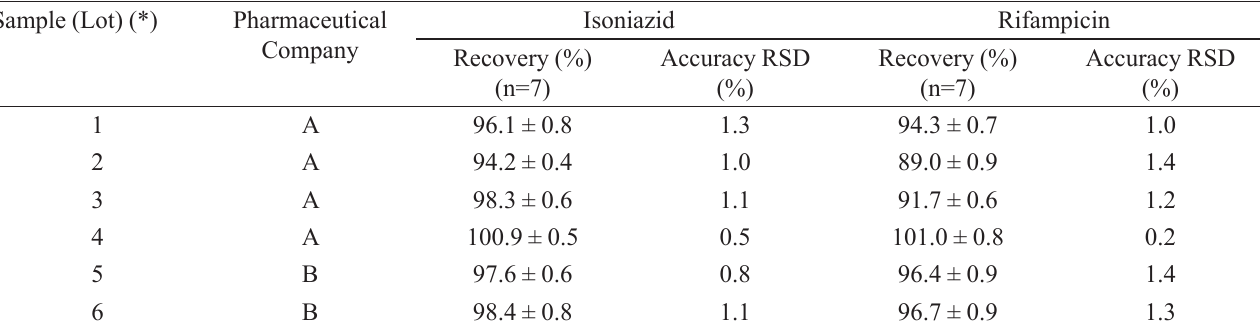
TABLE IV – Results found in medications from Pharmaceutical Companies A and B, using differential pulse voltammetry, under the conditions described at Table